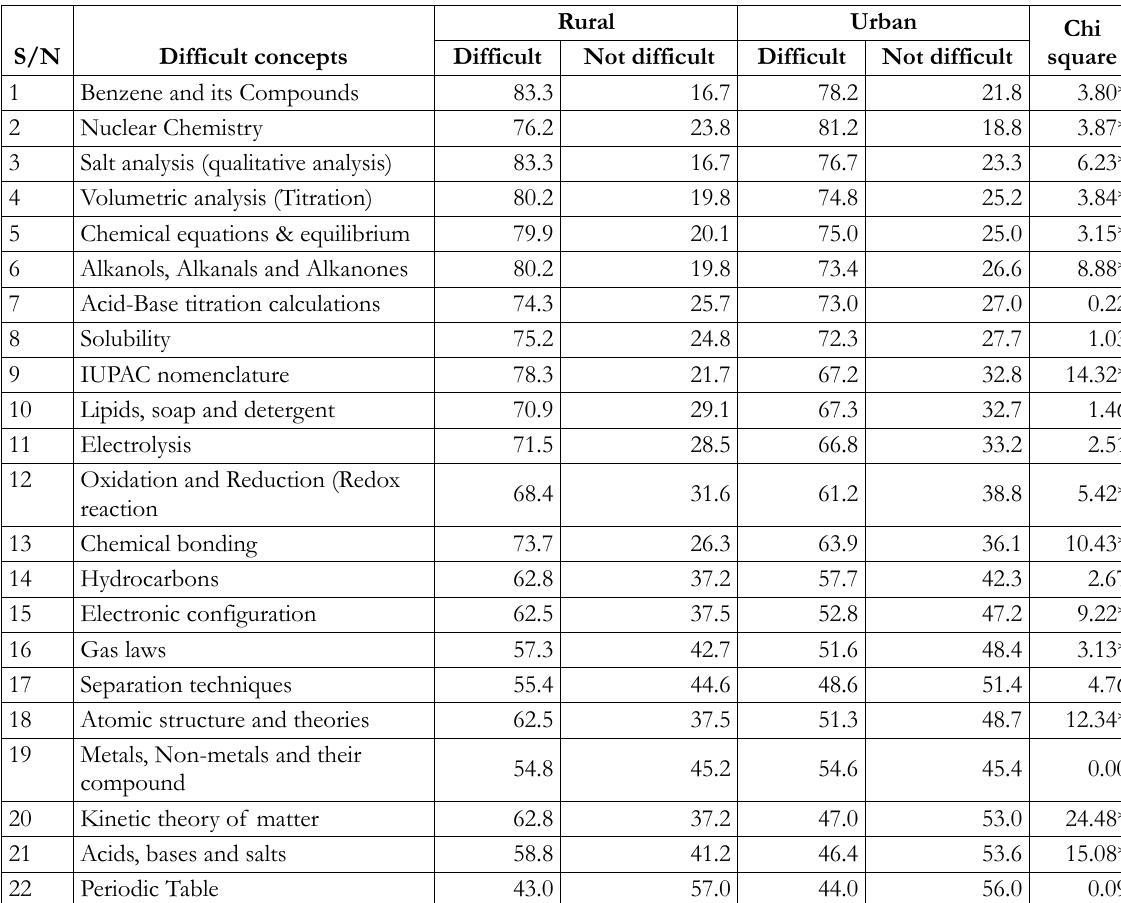
Table 3. Chi-square analysis of concepts perceived as difficult by students in rural and urban